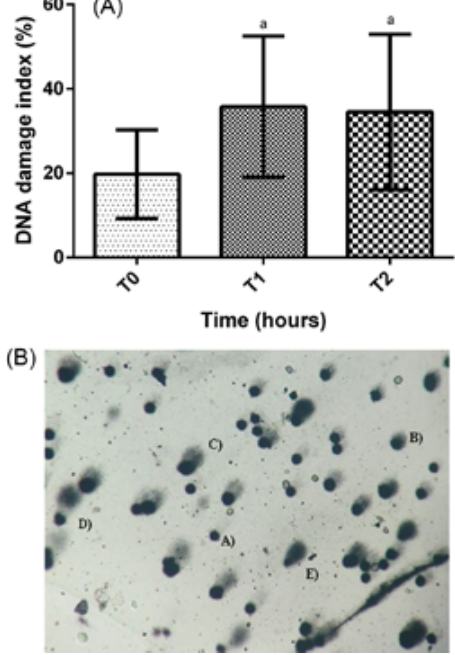
FIGURE 2 – Quantification of DNA damage through the comet assay (A). Photomicrography of comet assays on lymphocytes (B). The data were processed by analysis of variance